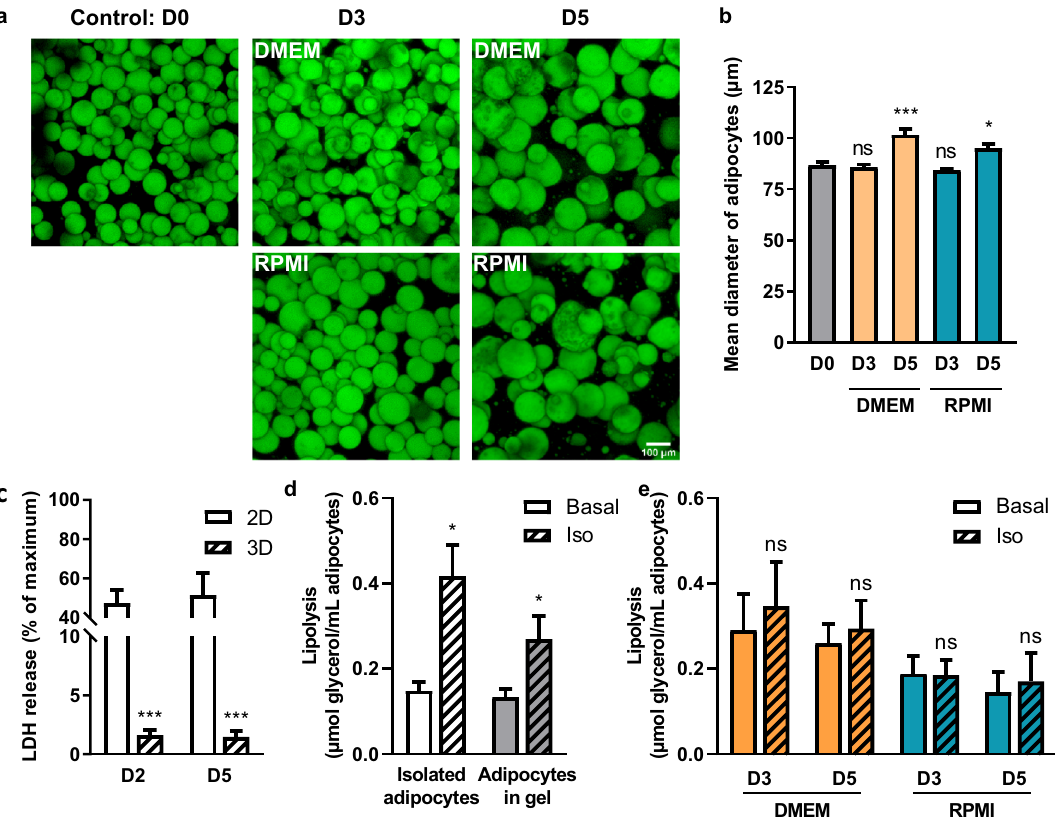
Figure 2:. 3D fibrin matrix preserves adipocyte viability but not lipolytic function at high glucose concentration. ( a ) Maximum intensity projection of Z-stack acquired through confocal microscopy. Representative images of M-Ads after BODIPY 493/503 staining, cultured in fibrin matrix for the indicated time. Top, cultured with DMEM 25 mM glucose 10% FCS medium, bottom, cultured with RPMI 11 mM glucose, 10% FCS medium; Scale bar, 100 µm. ( b ) Mean diameter of adipocytes according to their culture medium over time. Between 200 and 300 adipocytes were measured per condition (n = 6). ( c ) Quantification of LDH released in medium during culture at the indicated time for M-Ads in 2D (n = 3) or 3D (n = 12) culture. ( d ) Amount of glycerol released after 3 h in the presence or not (basal lipolysis) of isoprenaline (iso) before gel inclusion (isolated adipocytes) or after 3 h in gel (adipocytes in gel) (n = 8). ( e ) Similar experiments were performed with adipocytes cultured in 3D matrix for the indicated time, in RPMI or DMEM (n = 7). Histograms represent mean ± SEM, ns non-significant, *P < 0.05, ***P <